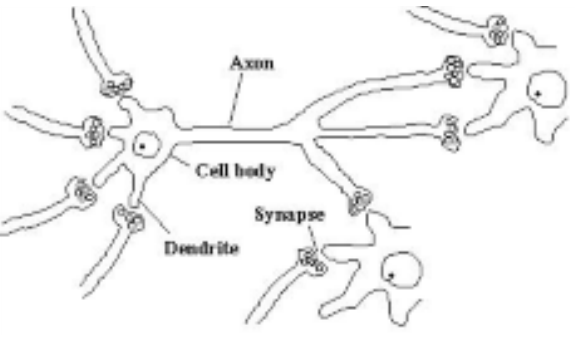
Figure 1: Simplified diagram of connecting neurons